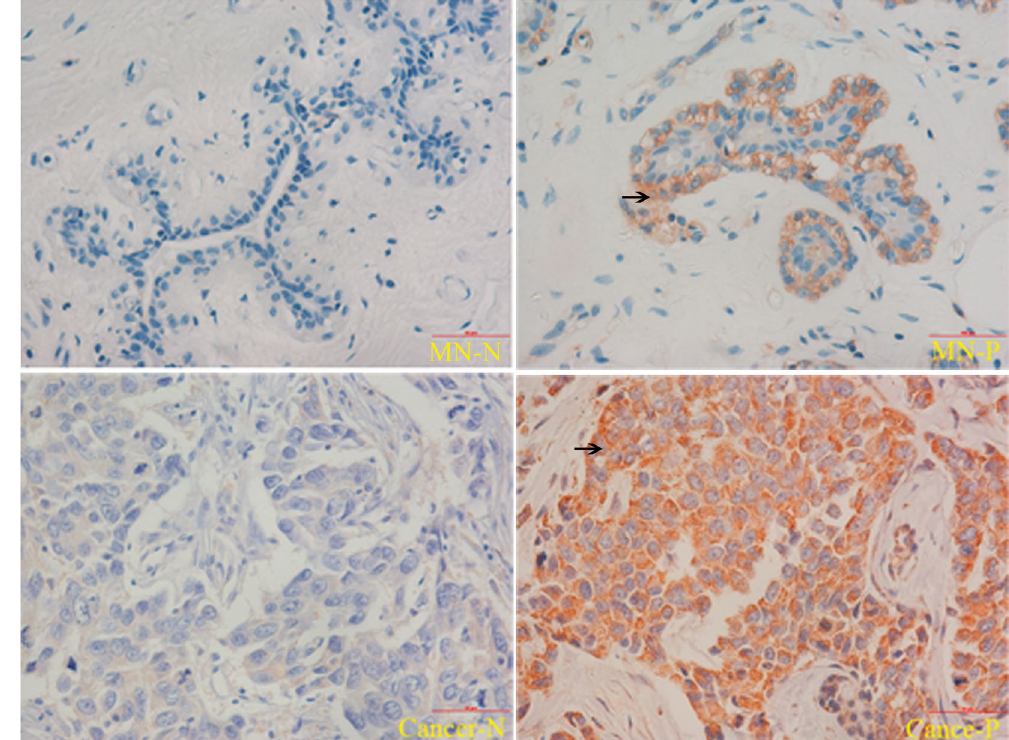
Figure 1. IHC of LDH-A in the breast cancer tissues and matched normal tissues. Patients showed the markedly different expression of LDH-A in the positive and negative cancer samples. MN-N: the matched normal tissue with LDH-A negative expression; MN-P: the matched normal tissue with LDH-A positive expression; Cancer-N: the cancer tissue with LDH-A negative expression; Cancer-P: the cancer tissue with LDH-A positive expression. The black arrows show LDH-A positive